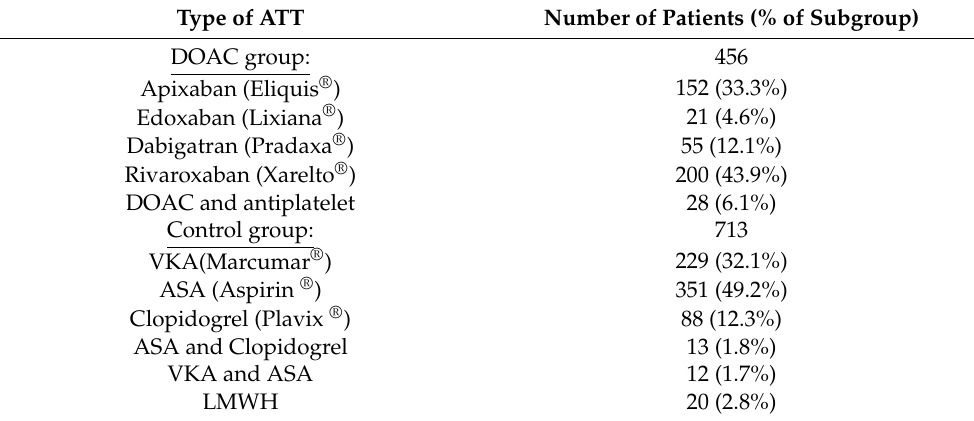
Table 1. Types of antithrombotic therapies in the DOAC group and in the control group. Type of ATT